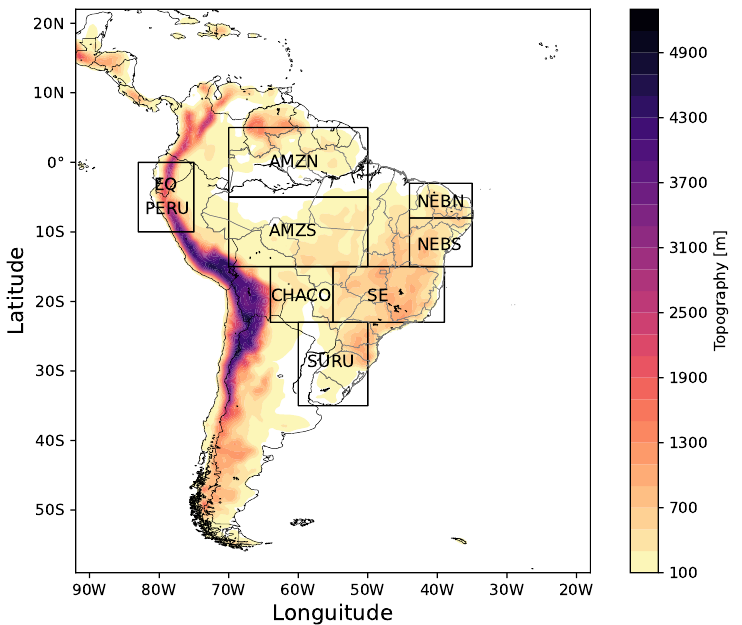
Figure 1. Domain and topography (m) used in the WRF simulations. The squares indicate the limits of sub-domains investigated. The abbreviations used in the map correspond to: Amazon basin NORTH (AMZN); Amazon basin SOUTH (AMZS); northeast of Brazil—NORTH (NEBN); northeast of Brazil—SOUTH (NEBS); southeast of Brazil (SE); south of Brazil and Uruguay (SURU); Chaco Region (CHAC), and Peru-Equator